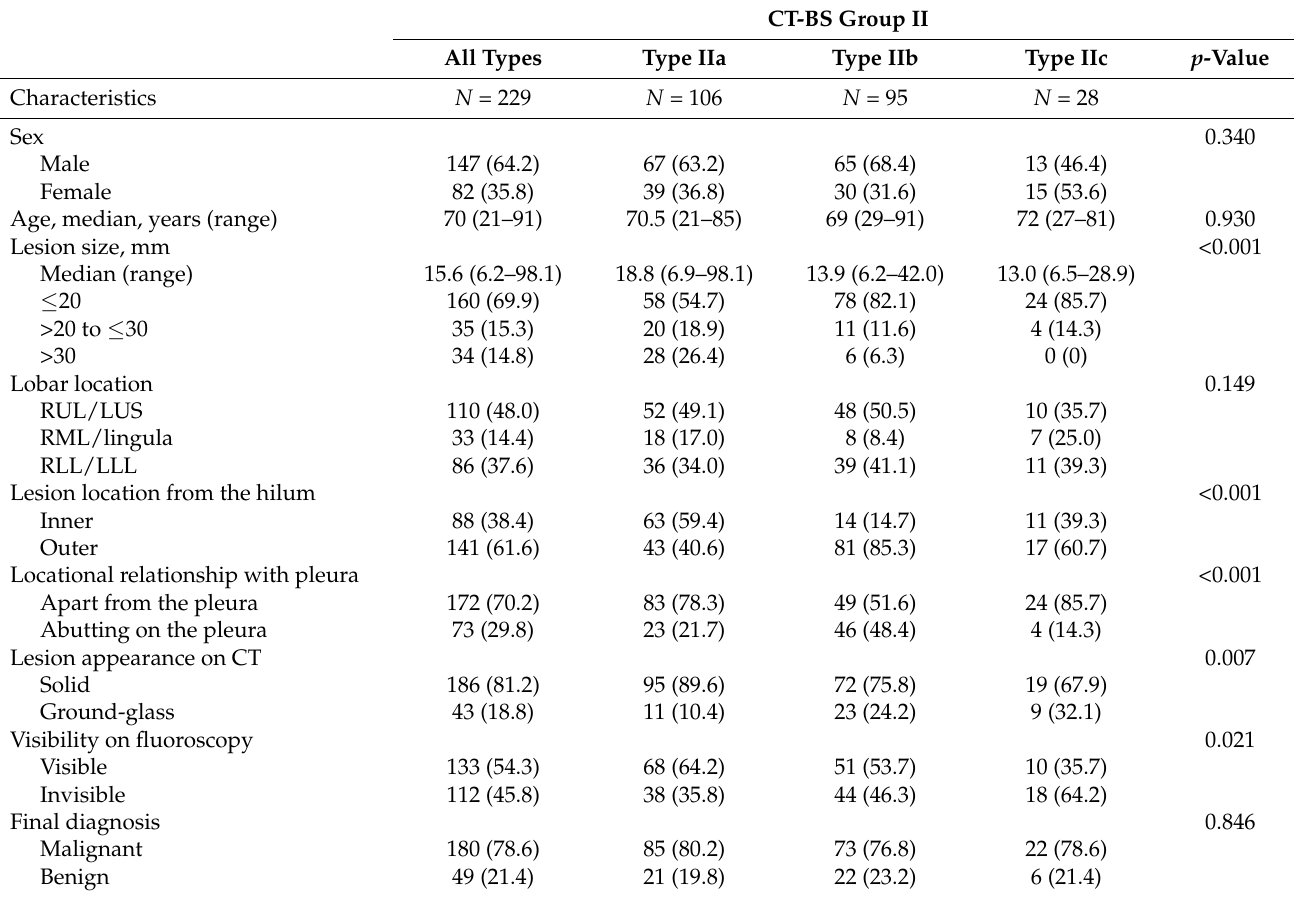
Table 2. Characteristics of patients and lesions in CT- group